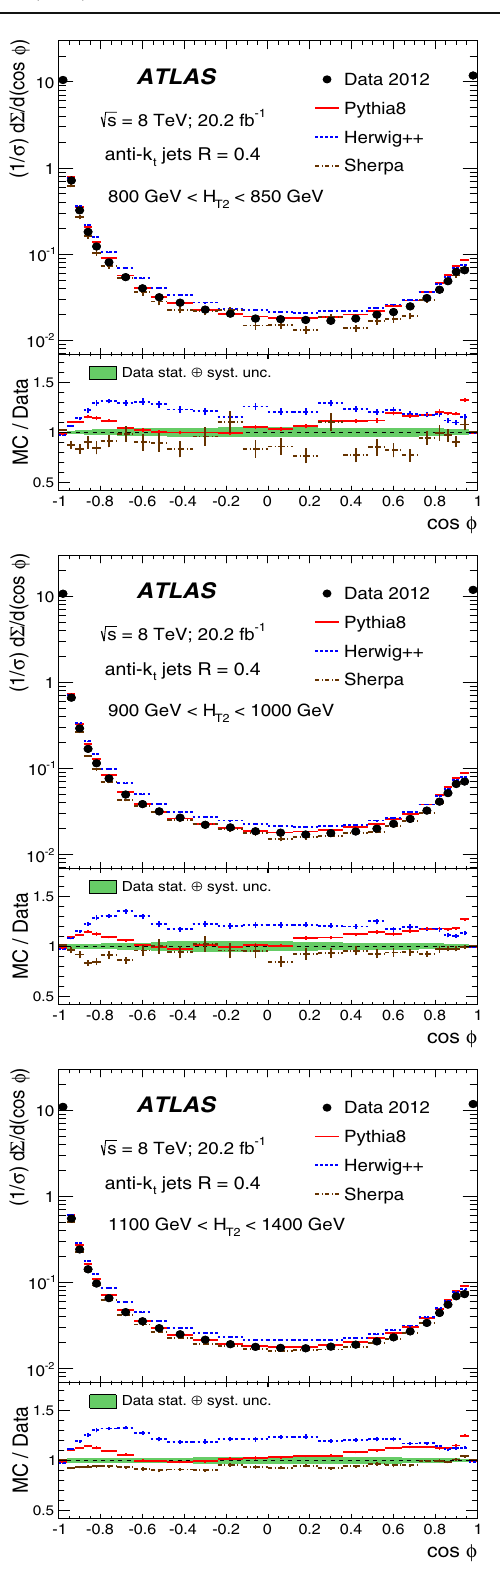
Fig. 3 Particle-level distributions for the TEEC functions in each of the H T2 intervals chosen in this analysis, together with MC predictions from Pythia8 , Herwig++ and Sherpa . The total uncertainty, includ-